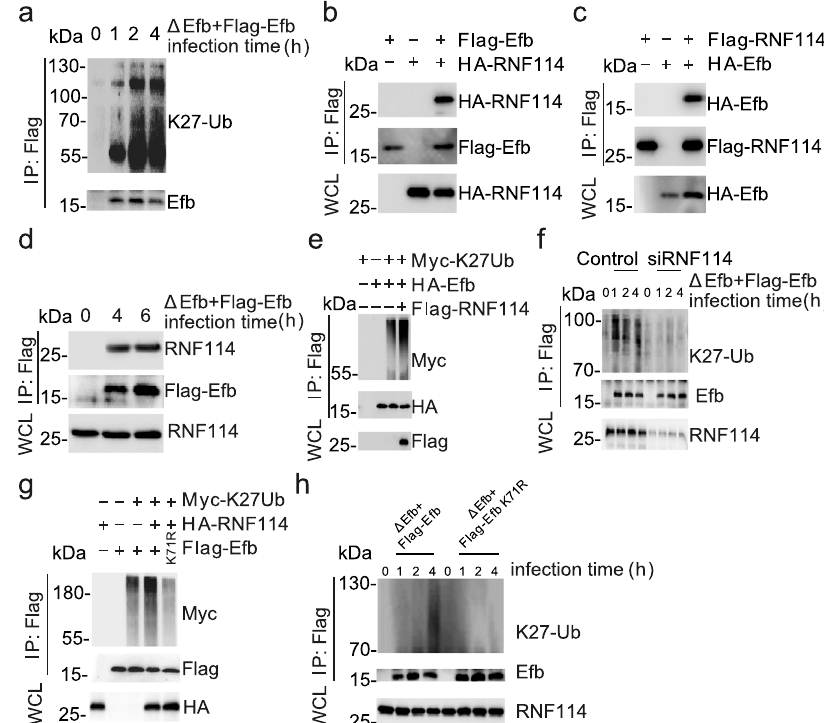
Fig. 5 | Efb is K27-ubiquitinated at K71 by host RNF114. a Immunoblots of IP products of WCL from MH-S infected with Δ Efb+Flag − Efb for indicated times (MOI=25). b , c ImmunoblotsofWCLandIPproductsfromWCLofHEK293Tcells transfected with indicated plasmids. d Immunoblots of IP products of WCL from MH-Sinfectedwith Δ Efb+Flag − Efbforindicatedtimes(MOI=25). e Immunoblots of WCL and IP products from HEK293T cells transfected with indicated plasmids. f Immunoblots of WCL and IP products from MH-S or RNF114 knockdown (KD)